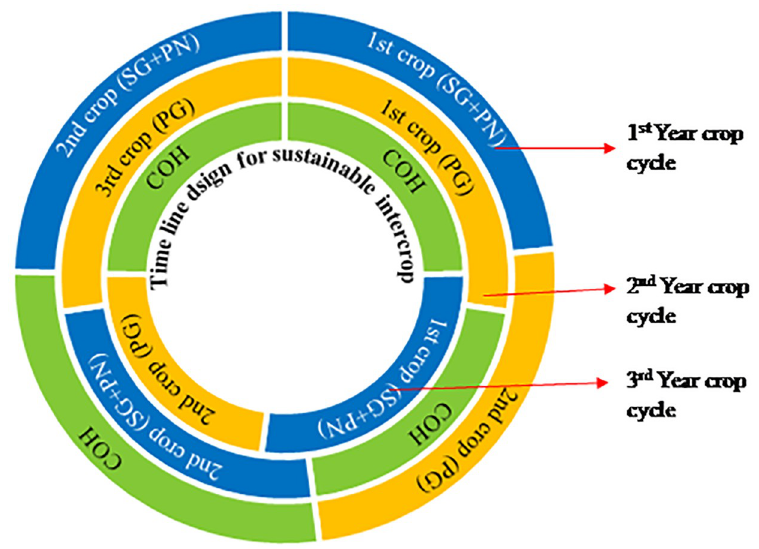
Fig 5. Proposed 3-year cyclic and sustainable intercropping farming system of Silver pompano in coastal Shrimp farms. Crop Over Hauling (COH); Shrimp Growout +Pompano Nursery (SG+PN); Pompano Nursery (PN).